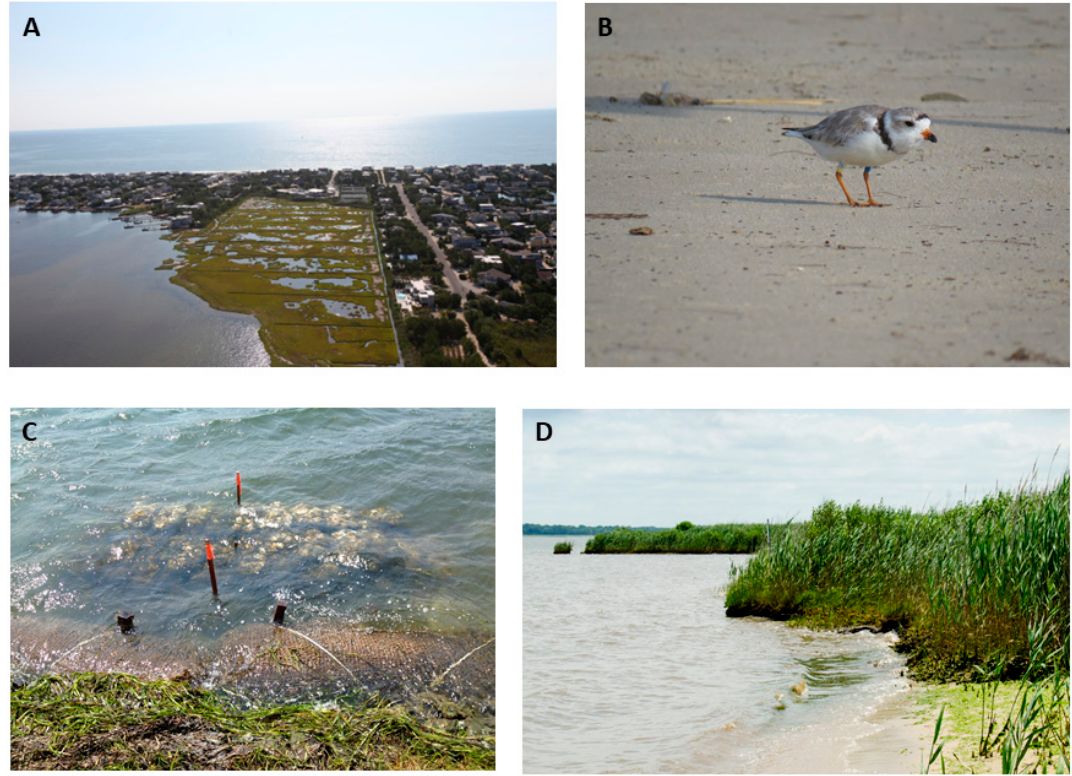
Figure 3. Salt marsh systems, shown here at E.B. Forsythe NWR in New Jersey ( A ), provide important coastal habitat for wildlife such as Piping Plovers ( B ) and also offer storm protection for seaside human communities. Many NWRs along the eastern coast of the United States utilize NbS to make areas more resilient to climate change, such as this oyster reef constructed at J.H. Chafee NWR in Rhode Island ( C ) and living shoreline at Eastern Neck NWR in Maryland ( D ). NbS can also address climate uncertainty since they expand over time and are capable of responding to unanticipated changes. Photo credits: ( A , C ), Lia McLaughlin/USFWS; ( B ), USFWS; ( D ), Alexander Jonesi/Chesapeake Bay Program.